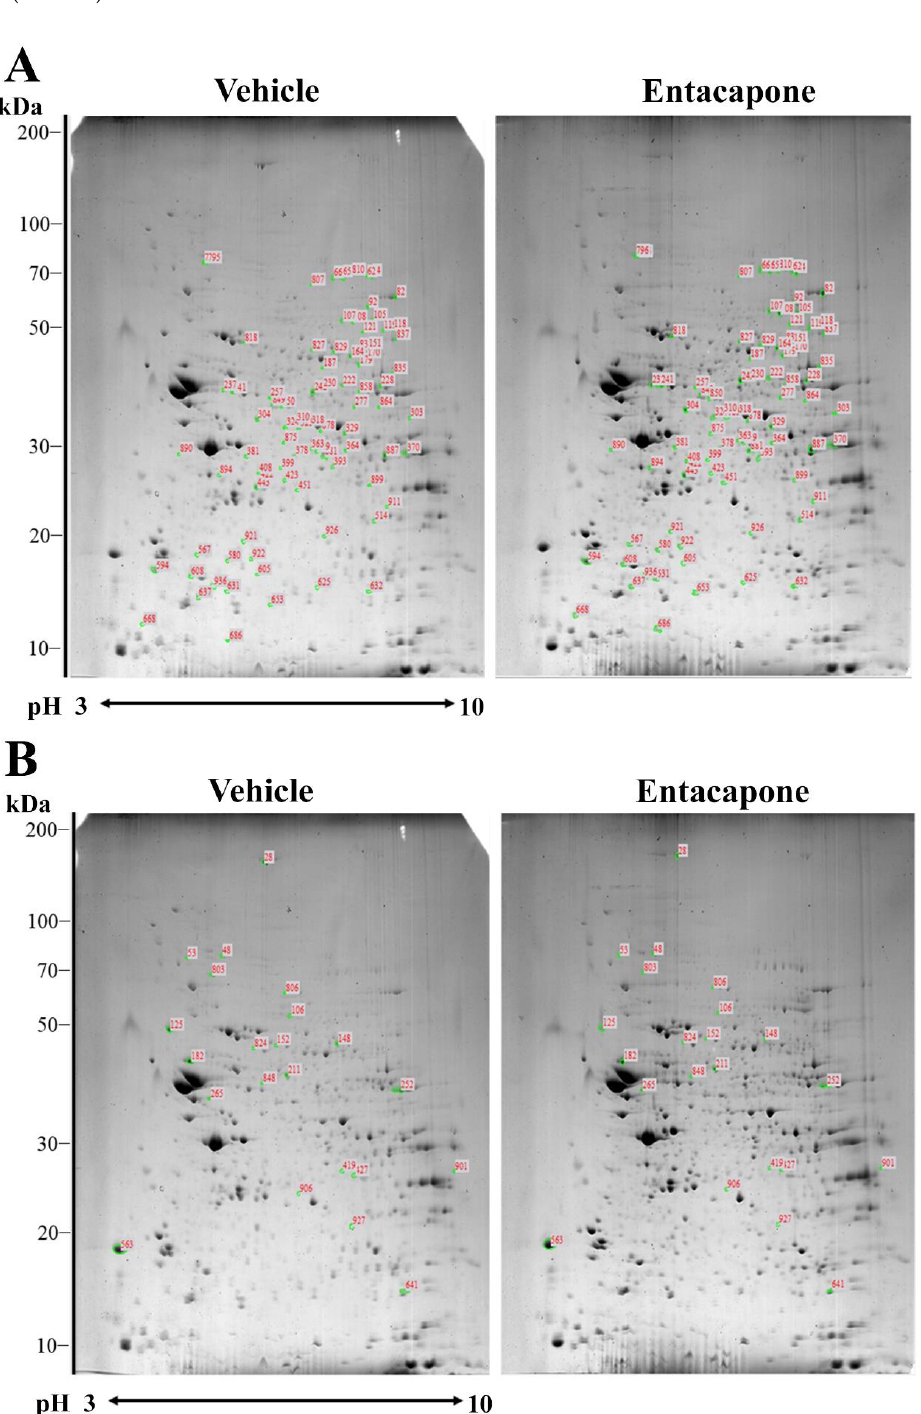
Figure 1. Two-dimensional electrophoresis (2-DE) gel pattern of hippocampal proteins extracted from the vehicle- and entacapone-treated groups. The spots labeled with red numbers indicate that the expression level of corresponding proteins is upregulated ( A ) or downregulated ( B ) more than two-fold following entacapone treatment. Proteins extracted from both groups were applied to immobilized pH 3 – 10 non-linear gradient strips, and then were separated with 9 – 16% sodium dodecyl sulfate (SDS)-polyacrylamide gels. Gels were stained with Coomassie brilliant blue G 250 solution.